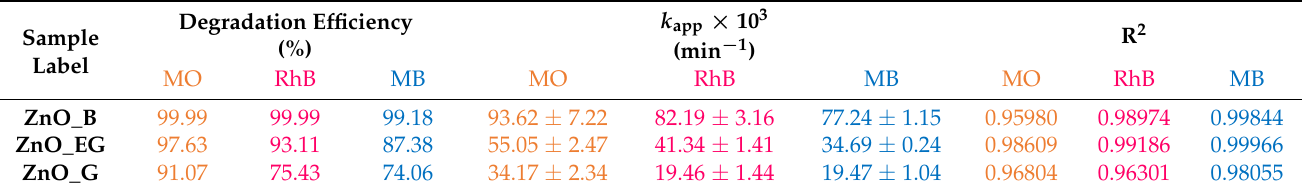
ZnO_EG and ZnO_G samples against dyes mixture